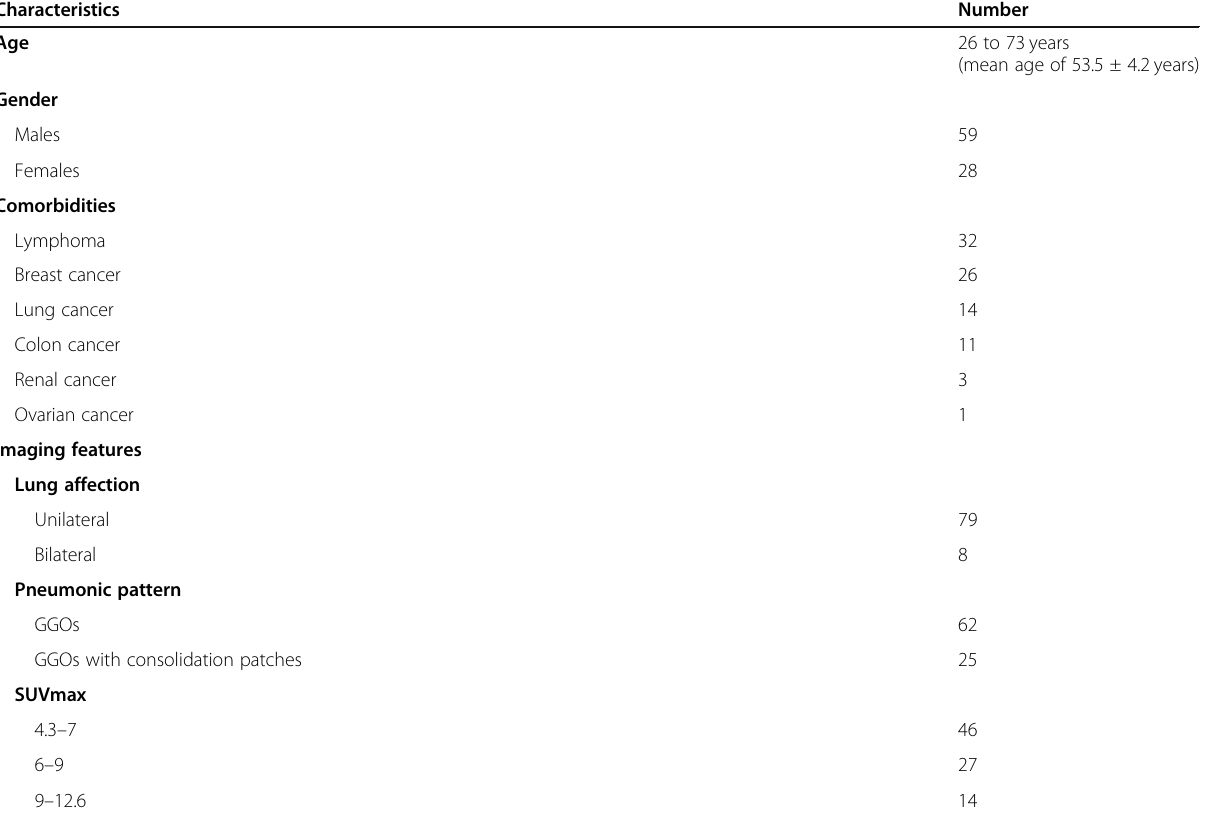
Table 1 Demographic and imaging features of the study population